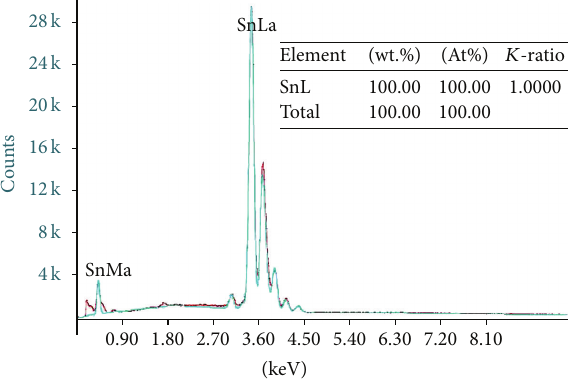
Figure 14: Sharp-edged oxidised lanthanum phase in Al 2 O 3 /Sn2La/ Al 2 O 3 joint.